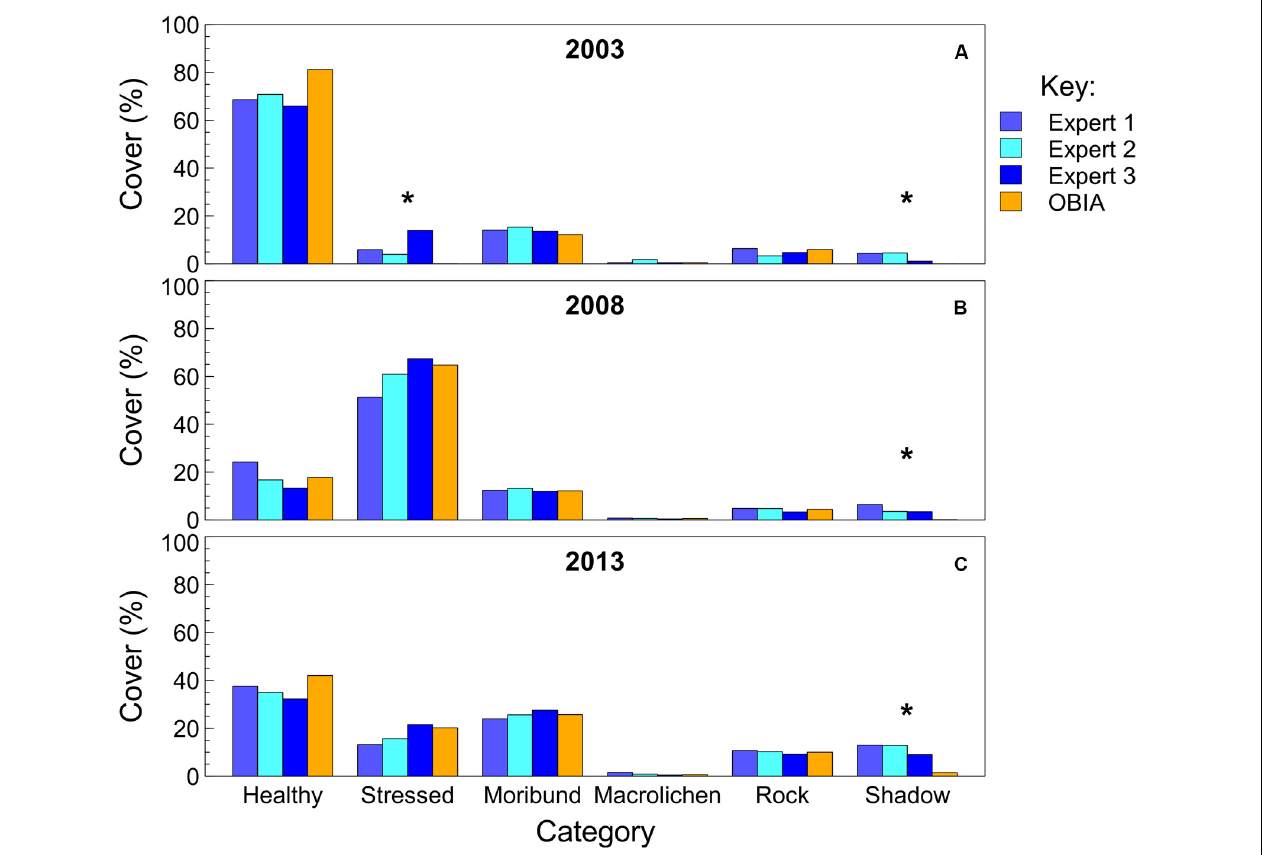
FIGURE 5 | Comparison of percent cover estimates from three experts and the semi-automated object-based image analysis (OBIA). Quadrat images assessed were the bottom row of the mosaic in Figure 1 , from (A) 2003, (B) 2008, and (C) 2013. Asterisks indicate significant differences between observers within each class in each